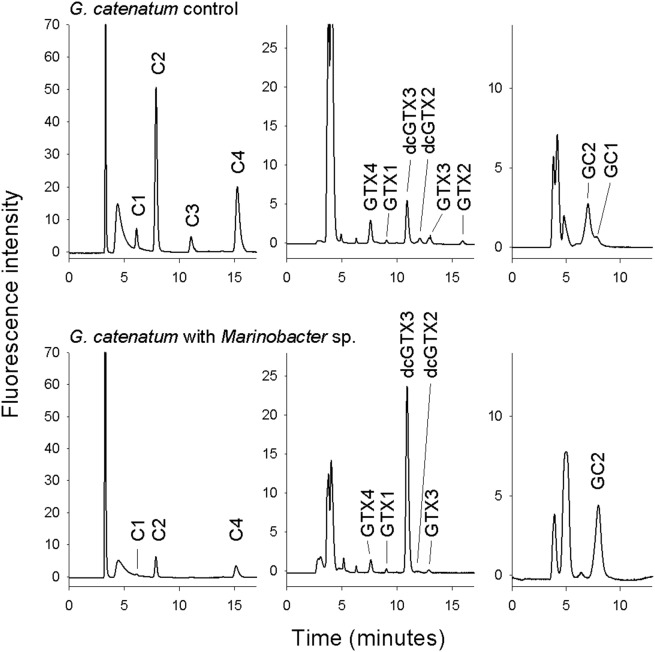
HPLC chromatogram comparison.Comparison of (a) Gymnodinium catenatum positive control (DE06 x LV01 cross with natural bacterial assemblage) and (b) with the addition of Marinobacter sp. DG879 (Gc/Mar).